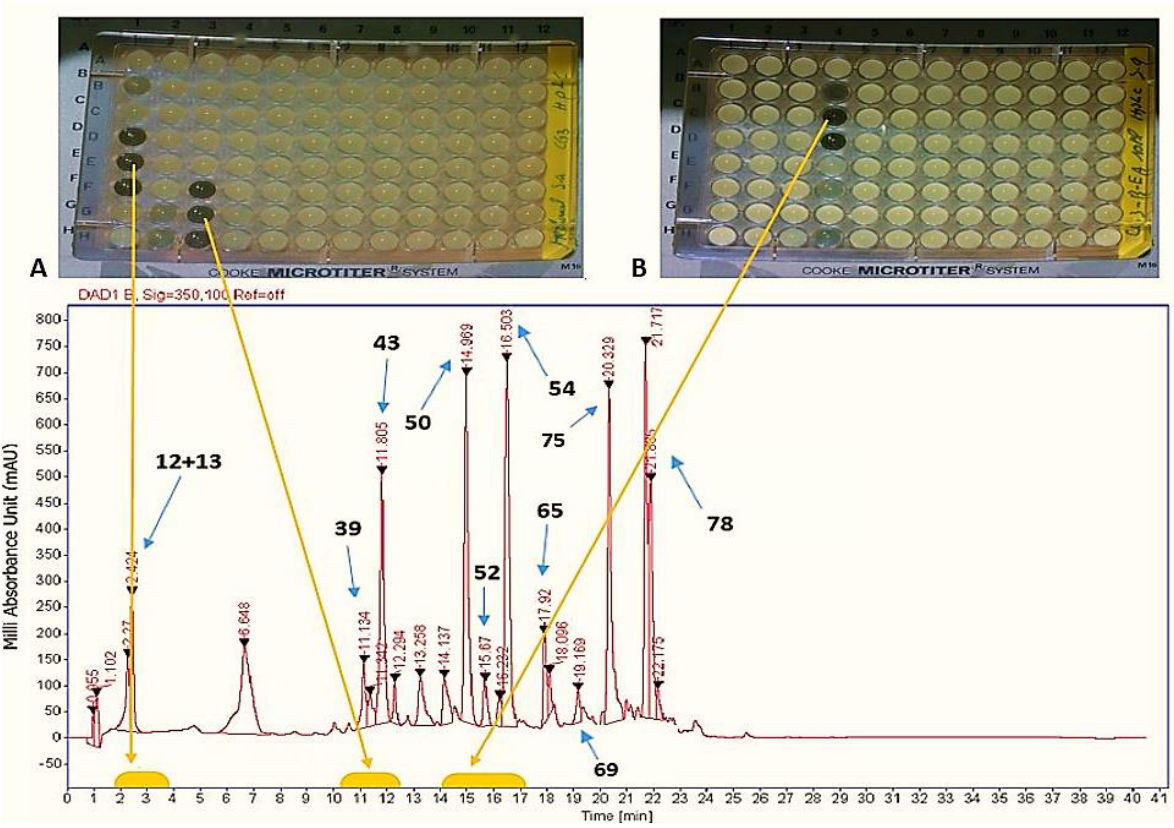
Figure 1. HPLC chromatogram of the crude extract from SM fractionated and tested against ( A ) Staphylococcus aureus; ( B ) Mucor hiemalis .